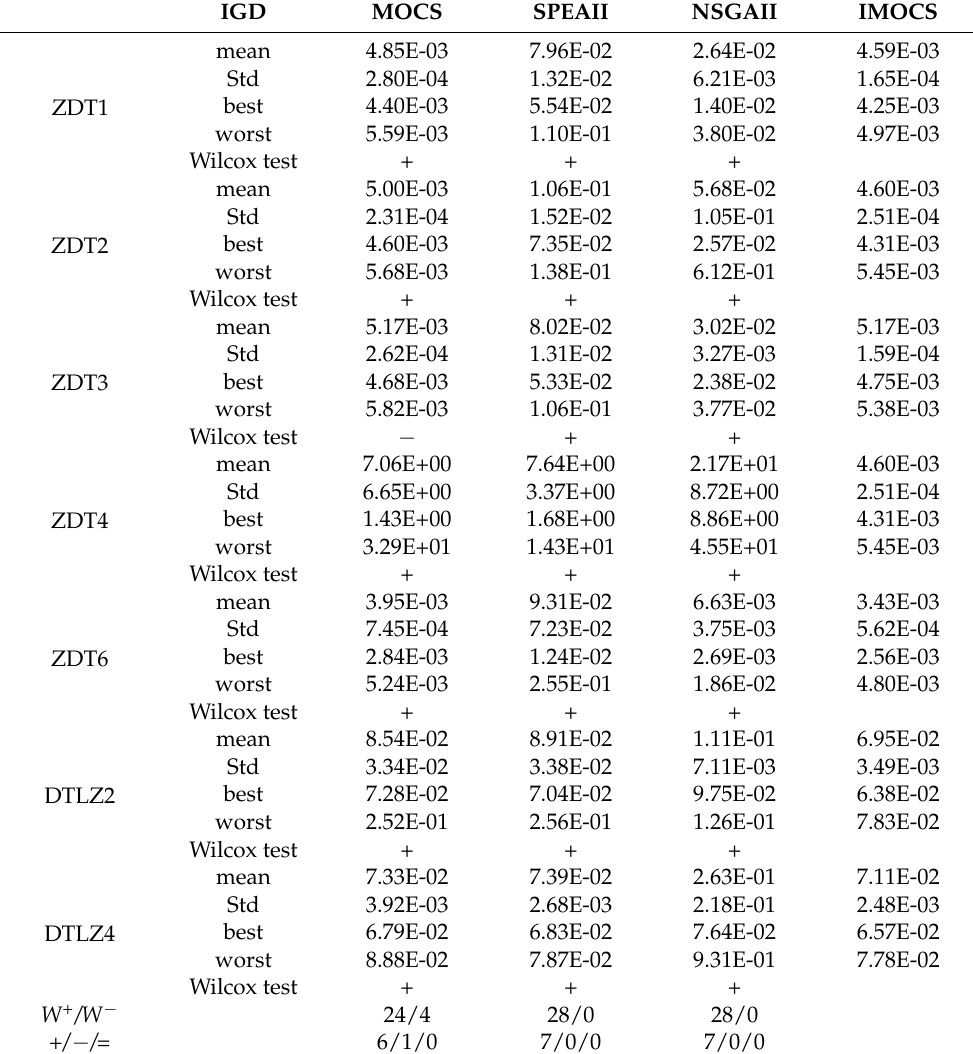
Table 4. Related statistical data based on the